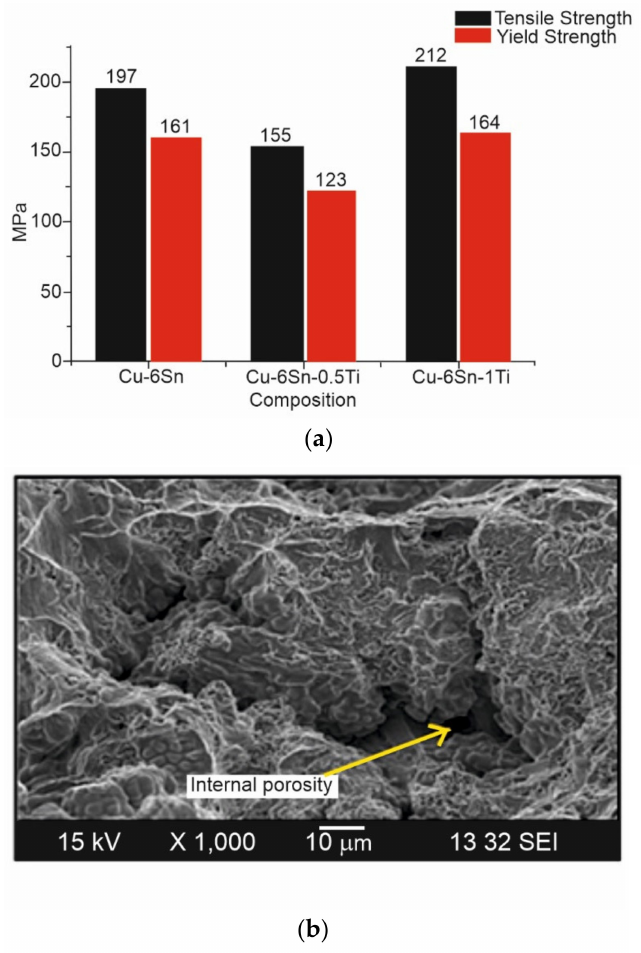
Figure 34. ( a ) Comparison of yield strength and tensile strength of as-cast alloys, ( b ) SEM image of a fracture surface of Cu-6Sn-0.5Ti